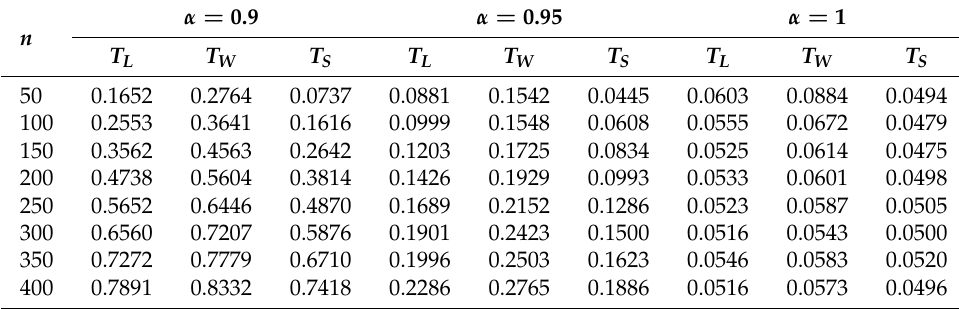
Table 7. The empirical levels/powers of statistics ( T L , T W , T S ) for Case (A3).